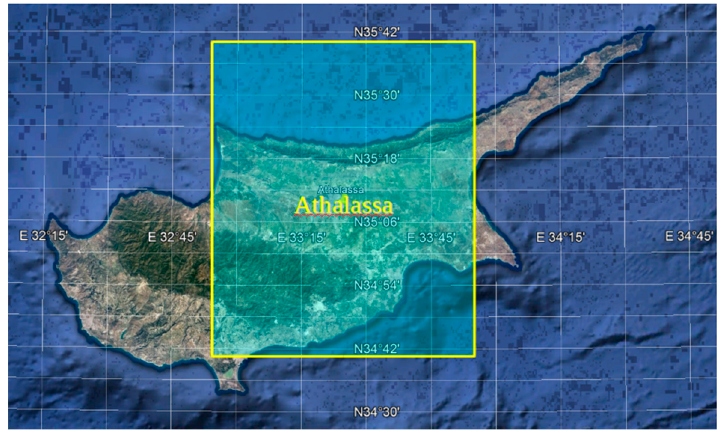
Figure 1. The 1 ° × 1 ° sub-region of ECMWF data centered over Athalassa. Figure 1. The 1 ◦ × 1 ◦ sub-region of ECMWF data centered over